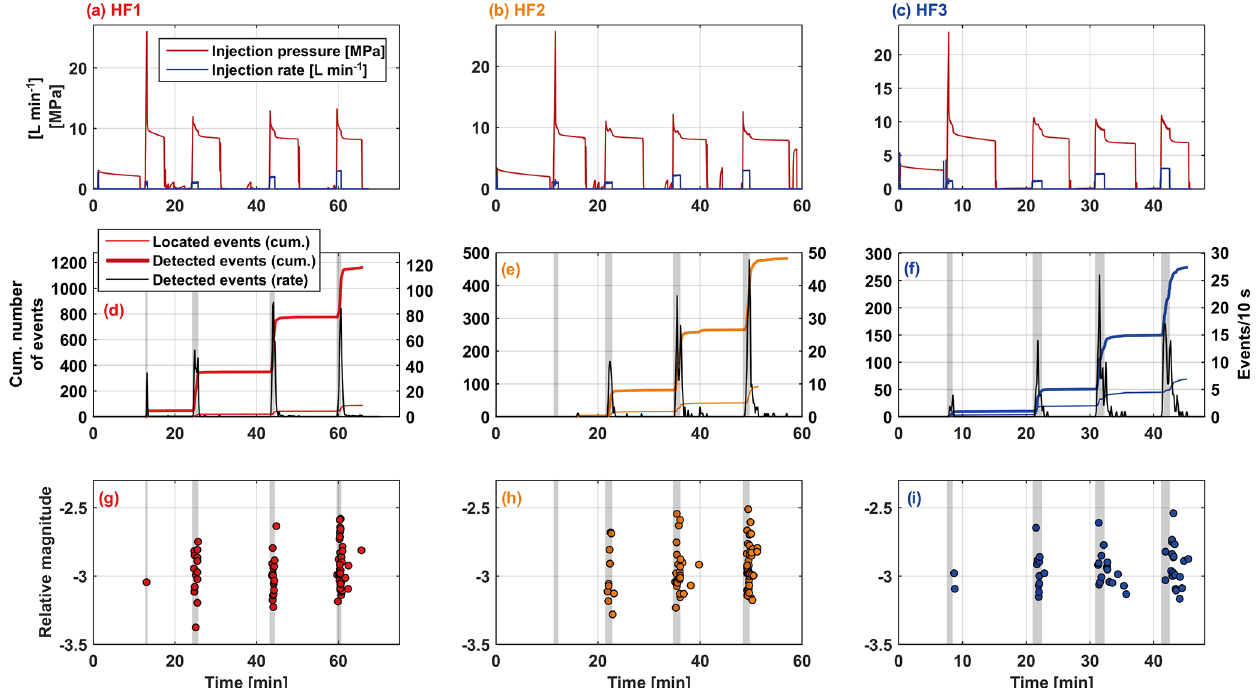
Figure 2. Temporal evolution of seismic events during hydrofracturing tests in SBH-3. Panels (a–c) show injection rate and pressure, panels (d–f) show the cumulative number of events and panels (g–i) show the adjusted relative magnitude. Events occur mostly during injections (grey shaded areas), but some events occur after shut-in.